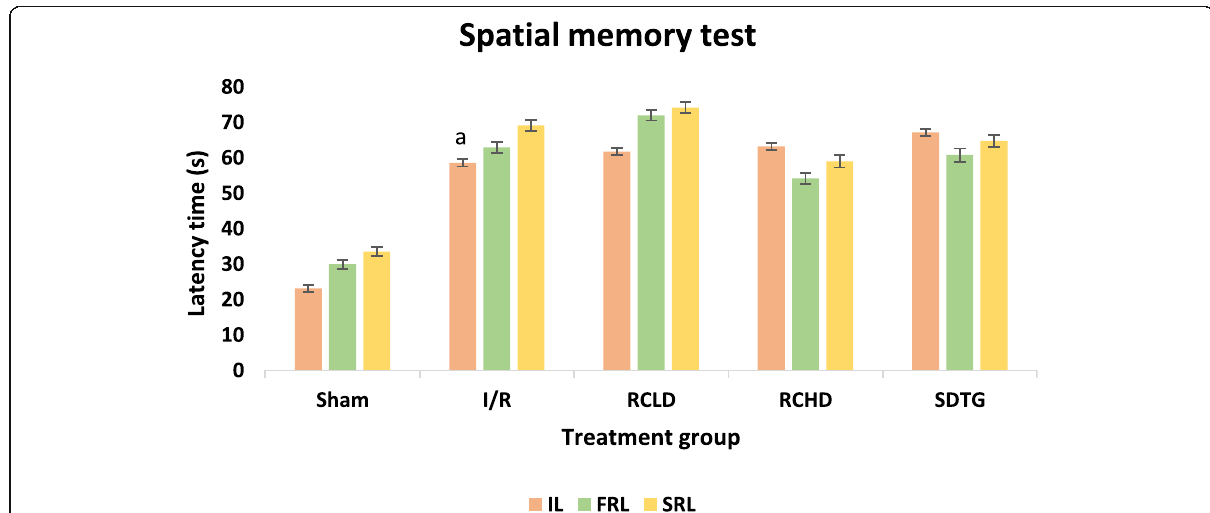
Fig. 4 Spatial memory test via elevated maize model in the different treatment groups. Where, values are indicated as mean ± SEM; ( n = 5) in each group. Data were subjected to one-way ANOVA followed by Dunnett ’ s test when RCLD, RCHD, and SDTG groups were compared to the I/R group, while the I/R group was compared to the Sham group. a p < 0.01, when compared to Sham Group, b p < 0.05, c p < 0.01, d p < 0.001 when compared to I/R